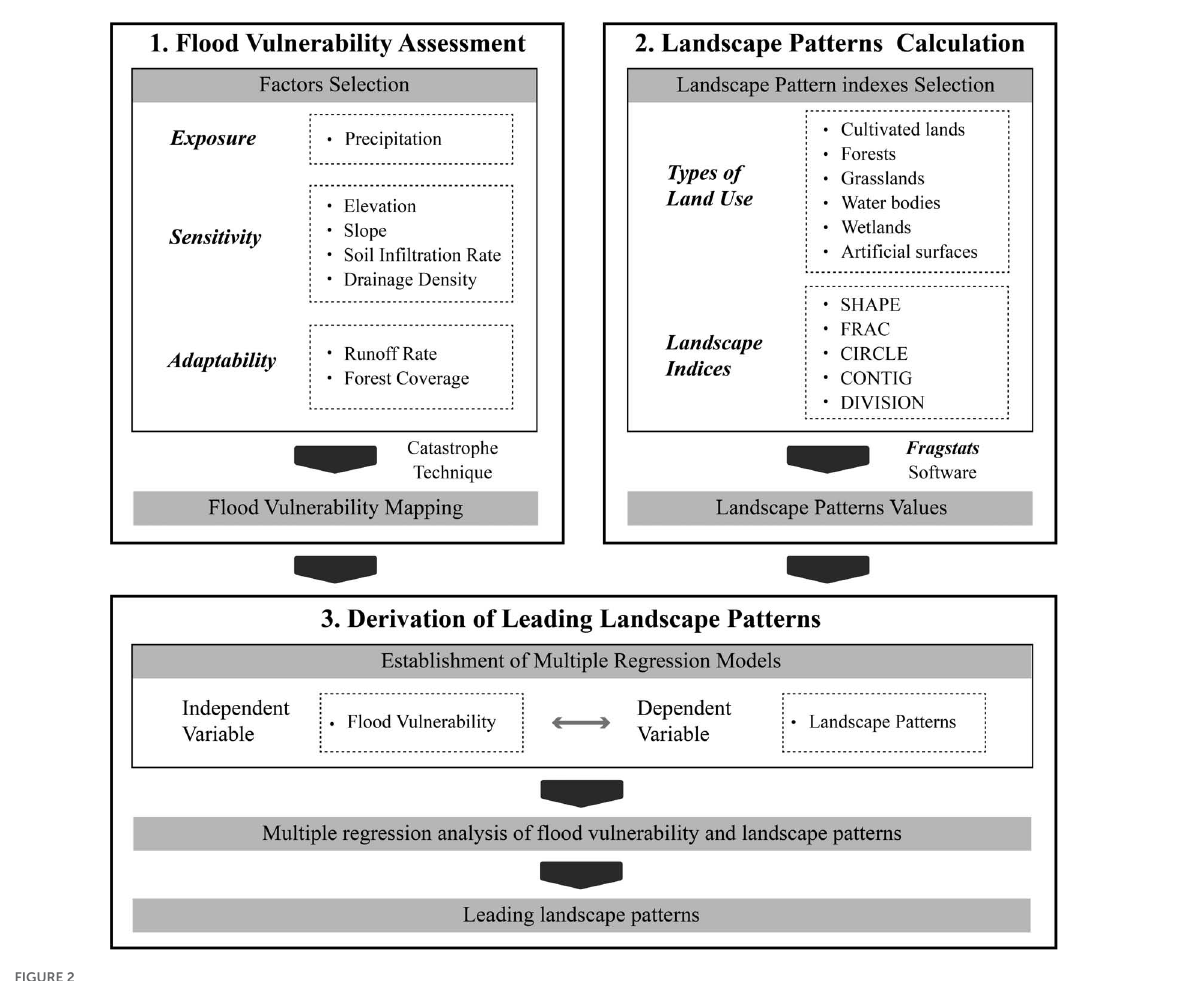
FIGURE2 Research